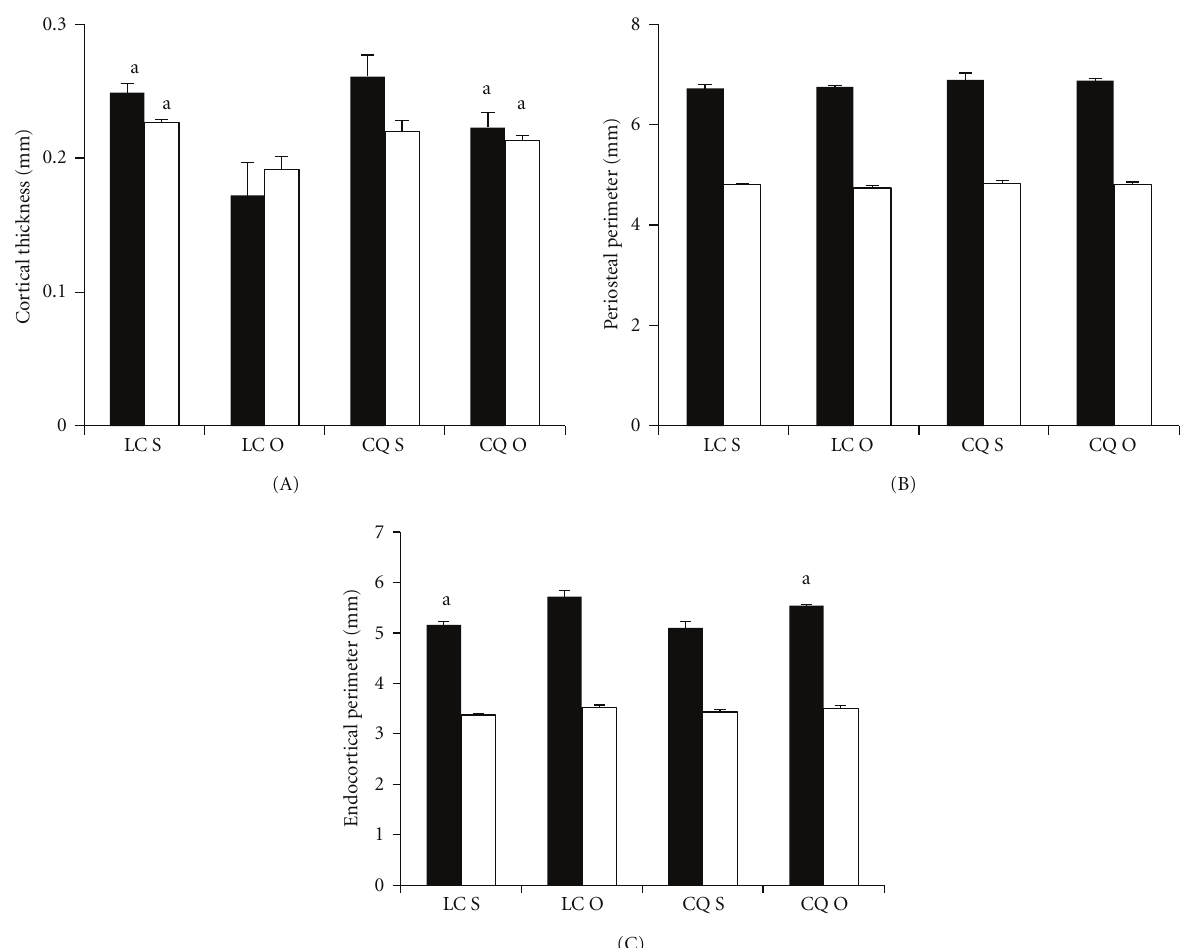
Figure 2: E ff ects of Cissus quadrangularis on the cortical bone thickness and perimeters of the distal femoral metaphysis and femoral diaphysis of C57Bl/6 mice after ovariectomy using pQCT. Data are Mean ± SE. (A) Cortical thickness; (B) periosteal perimeter; (C) Endocortical perimeter. Black bars represent distal femoral metaphysis; white bars represent femoral diaphysis. LC S: lab chow sham; LC O: lab chow ovariectomy; CQ S: Cissus quadrangularis sham; CQ O: Cissus quadrangularis ovariectomy. a P < 0 . 05 versus LC